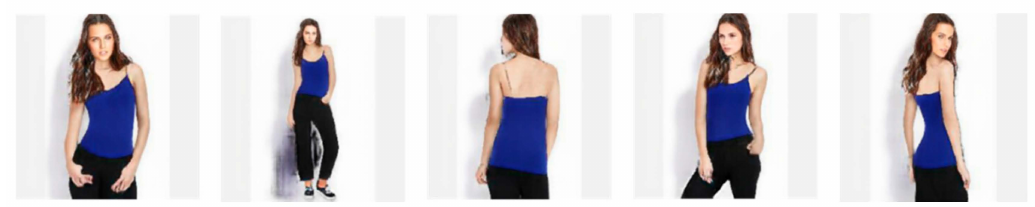
Figure 12. Creating images of a model in various poses.